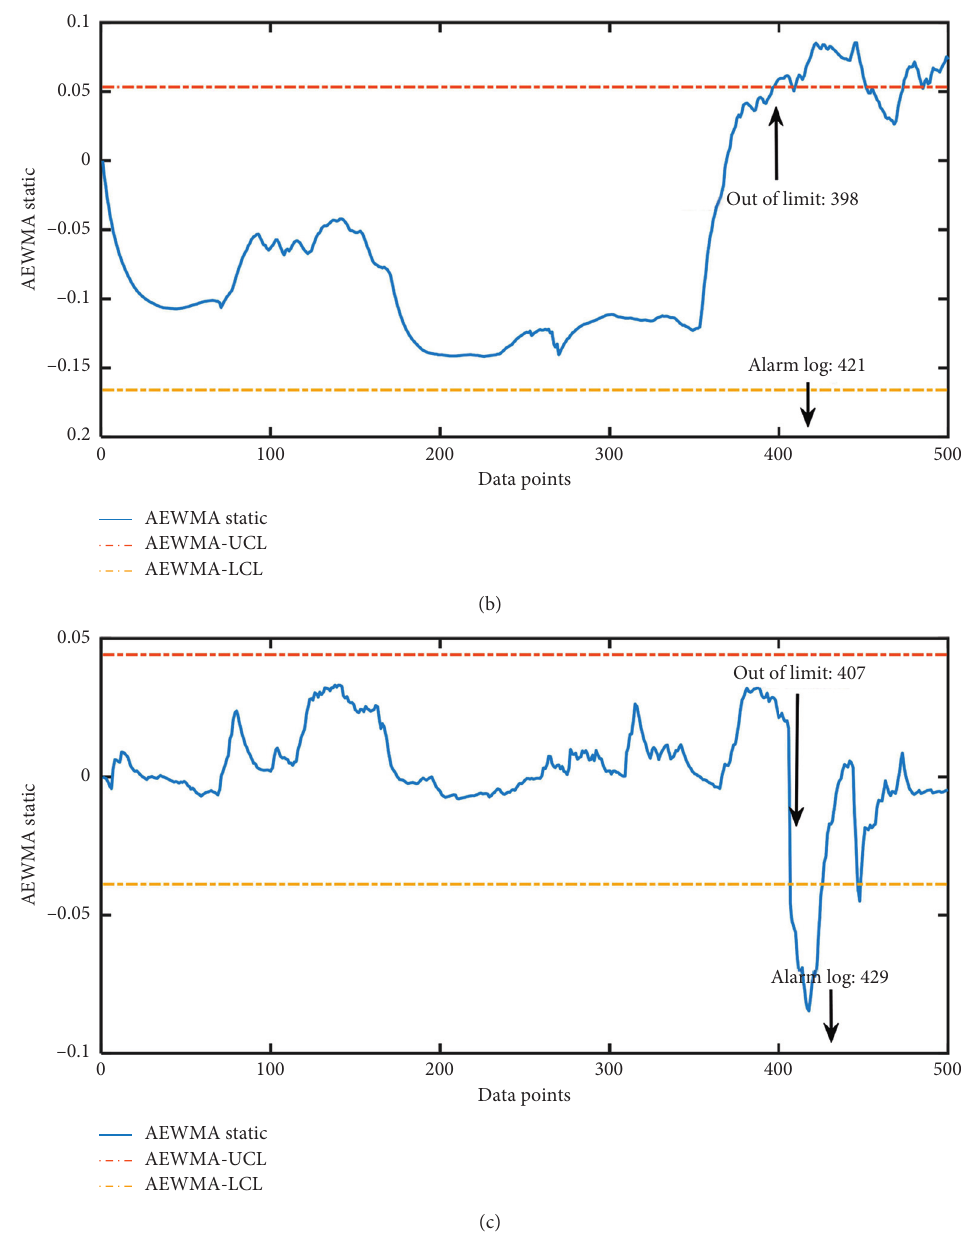
Figure 6: Residuals monitored by AEWMA control chart with (a) anomaly A, (b) anomaly B, and (c) anomaly